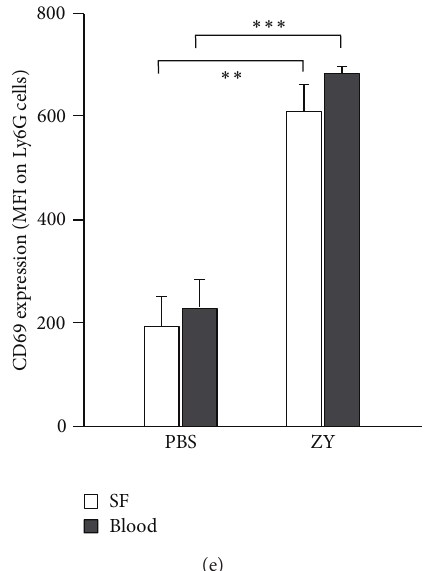
Figure 1: Arthritis induced by intra-articular TLR2 ligand (zymosan; ZY) injection into BALB/c mice. (a) Representative photomicrographs of hematoxylin and eosin (H&E) stained ankle sections show cell infiltration (arrow, I) and cartilage erosion (arrows, E) at day 7 of zymosan injection (200 𝜇 g/10 𝜇 L per ankle) (magnification 40x). (b) Photomicrographs of Safranin O stained sections (magnification 100x) and scores for cell infiltration (I), proteoglycan loss (PG loss), and cartilage erosion indicates severe joint injury in zymosan-injected mice (ZY) in comparison to PBS-injected group (PBS). Values are the mean ± SEM (10 sections/mouse; 𝑛 = 10 mice/group; 5 experiments). ∗∗∗ 𝑃 < 0.001 , Kruskal-Wallis and Mann-Whitney U -test. (c) Increased IL-17 amounts in SF and serum of mice with arthritis (day 7). Bars show the mean ± SEM ( 𝑛 = 5 mice/group; 3 experiments). ∗ 𝑃 < 0.05 ; ∗∗ 𝑃 < 0.01 , Student’s 𝑡 -test. (d) Cells accumulate in SF and frequencies of Ly6G + CD11b + cells increase in SF and blood at day 7 of arthritis. Values are the mean ± SEM ( 𝑛 = 10 mice/group; 5 experiments). ∗∗ 𝑃 < 0.01 ; ∗∗∗ 𝑃 < 0.001 versus healthy (H) or versus PBS-injected groups (PBS), Student’s 𝑡 -test. (e) Blood and SF Ly6G + cells upregulate surface CD69 at day 7 of arthritis. Values are the mean ± SEM ( 𝑛 = 5 mice/group; 3 experiments). ∗∗ 𝑃 < 0.01 ; ∗∗∗ 𝑃 < 0.001 , Student’s 𝑡 -test. MFI: mean fluorescence